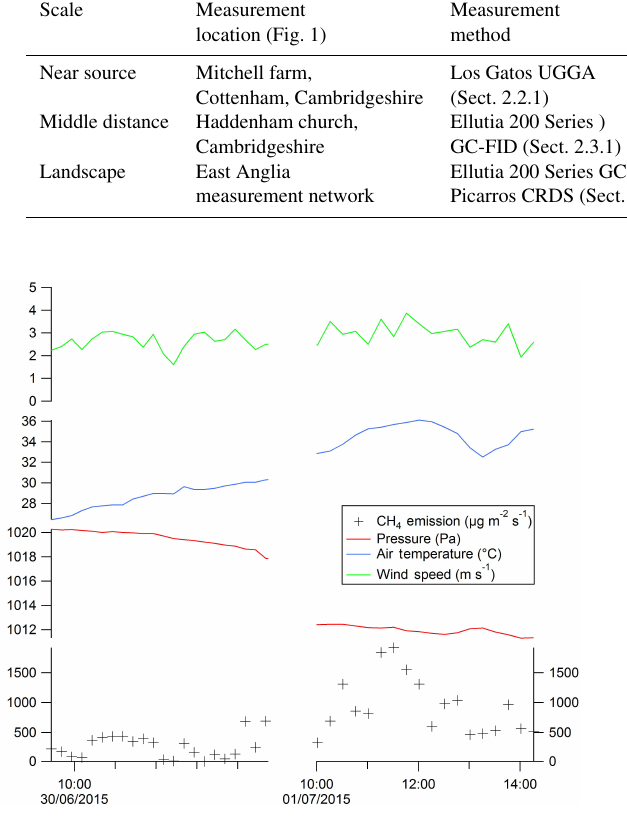
Figure 5. Methane emission rate as calculated by the Gaussian plume modelling approach (black crosses) and the WindTrax at- mospheric dispersion model (red crosses) from data collected at Mitchell Hill Farm, Cottenham, from the landfill at the Waterbeach Waste Management Park on 30 June and 1 July